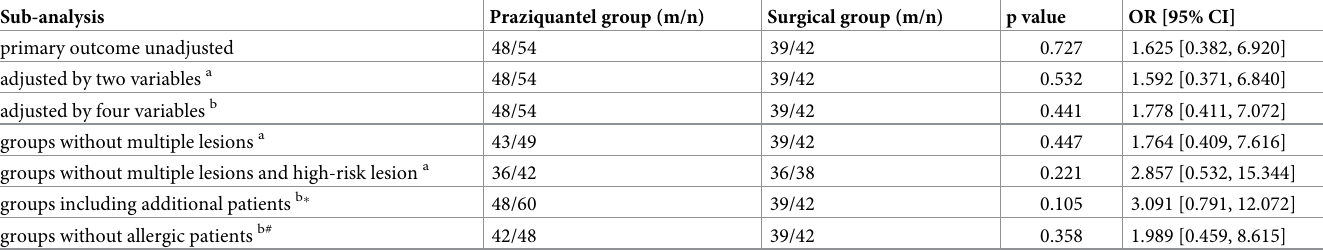
Table 3. Sub-analysis of primary outcome by binary logistic regression models.